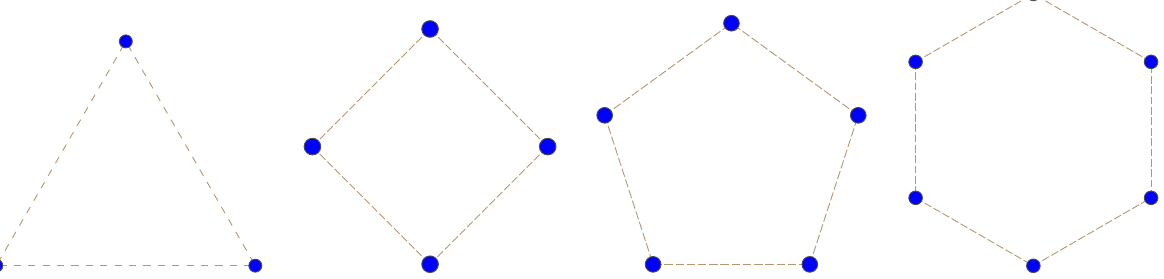
Figure 2. Examples with cyclic dominance. The individuals of the population are distributed over d colonies on a circle. From left to right: d = 3 ; d = 4 ; d = 5 ; d = 6 . Colonies are represented by full circles. Interactions and migration are possible only between colonies connected by dashed edges. The interaction and migration graphs are regular